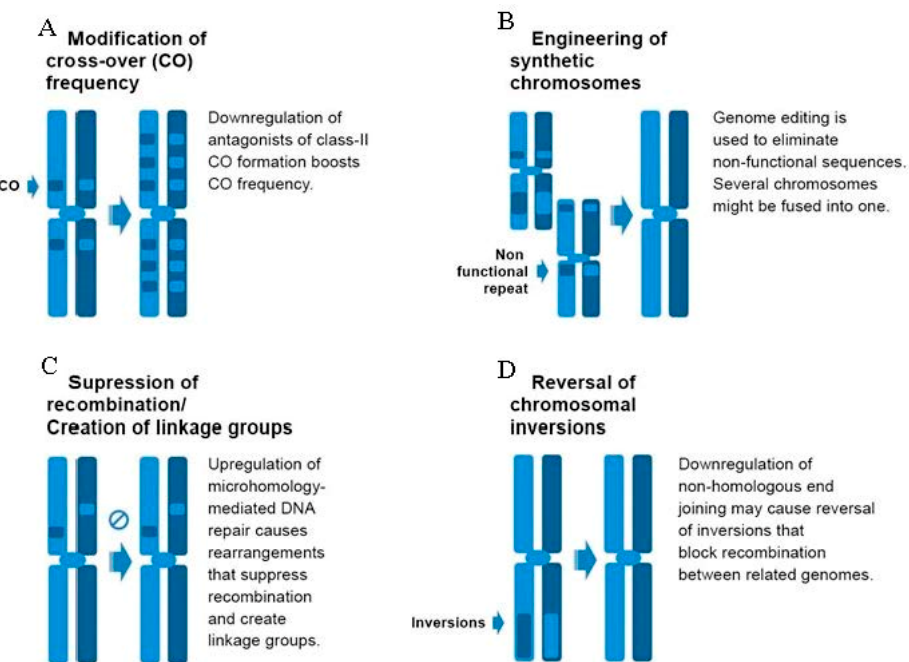
Figure 2. Possibilities for genome and chromosome engineering in tropical crops. ( A ) Modification of cross-over (CO) frequency, elimination or downregulation of meiotic antagonists of class II cross-over formation may lead to a significant increase in non-interfering cross-over formation, which may facilitate introgression of beneficial alleles from wild relatives. ( B ) Engineering of synthetic chromosomes, following the example of synthetic yeast strains, genome editing in plants may allow for the trimming of non-functional sequences, such as those corresponding to transposable elements, and facilitate the aggregation of open reading frames into so-called “Megachunks”. Eventually, megachunks from di ff erent chromosomes may be combined into few, fully functional chromosomes. ( C ) Suppression of recombination and creation of linkage groups. In somatic tissues, downregulation of non-homologous end joining (NHEJ) by targeting either the Ku70 / Ku80 heterodimer or the XRCC4 ligase leads to a shift to repair through backup EJ by DNA polymerase θ , which results in large deletions, inversions and translocations. These rearrangements may block recombination and lead to the de novo creation of new linkage groups that facilitate apomictic-like asexual reproduction. This trait may be useful for harvesting hybrid seeds that breed true to type in the next generation. ( D ) Downregulation of Ku70 / Ku80 may lead to large chromosomal inversions up to 18 Kb in length, which may help undo chromosomal rearrangements that may occur during the evolution of new closely related species; such ancestral rearrangements may result in di ffi cult recombination between chromosomes from commercial varieties and those from wild relatives. Downregulation of NHEJ may also facilitate CRISPR / Cas9-mediated genome